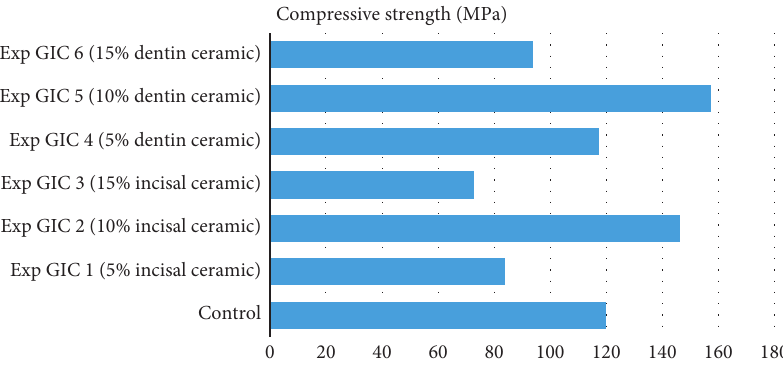
Figure 2: Compressive strength of samples in Group 2. Table 3: Film thickness and setting time of samples in Groups 1 and